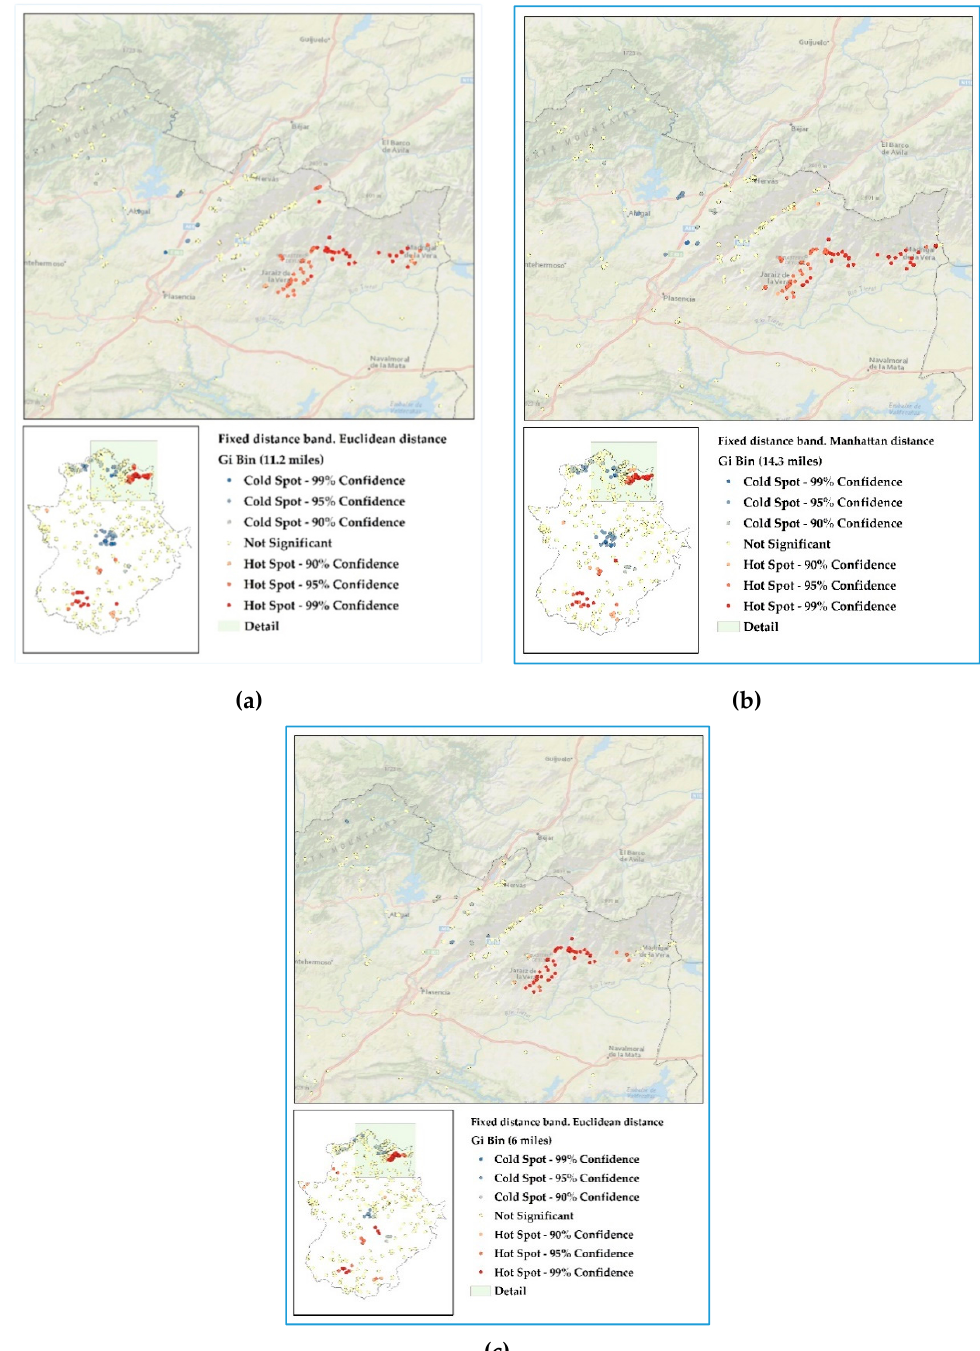
Figure 6. Hot spot analysis comparison (La Vera district details). Distance method: Euclidean distance ( a ), Manhattan distance ( b ) and Euclidean distance fixed band 6 miles ( c ). Conceptualization of spatial relationships: fixed distance band.